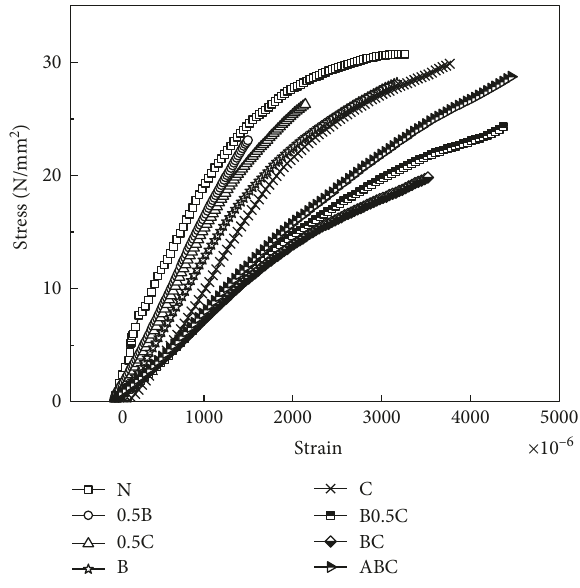
Figure 8: Stress-strain curve of concrete with the water to cement ratio of 0.47.